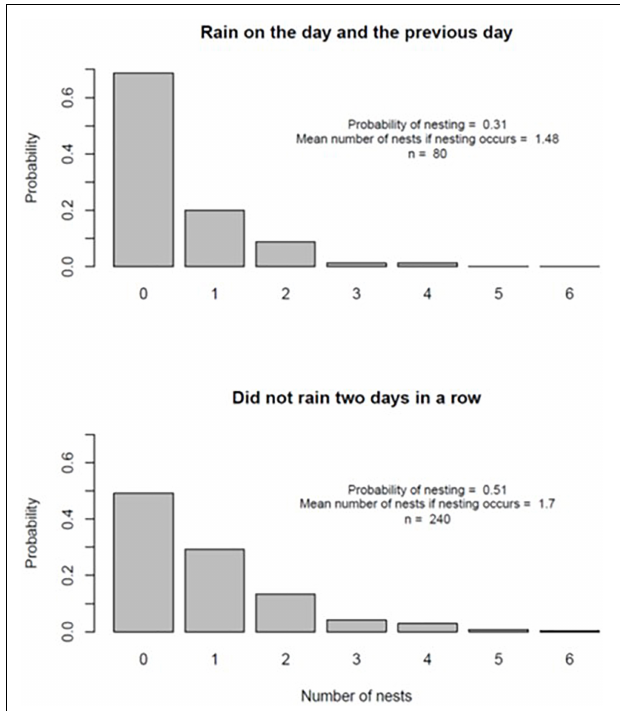
FIGURE 2 | Probability distributions for the number of nests constructed on days where it had rained two days in a row (top panel) and days where it had not (bottom panel)